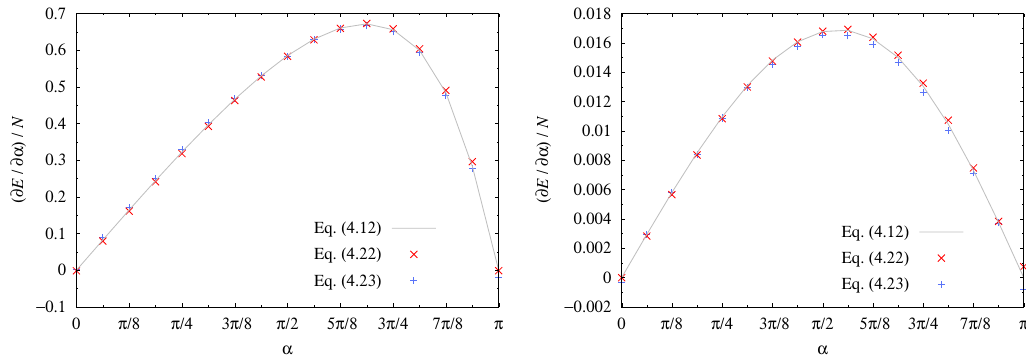
Figure 9. The (cid:11) dependence of the total energy E is numerically evaluated by using eq. (4.22) (red crosses) and eq. (4.23) (blue plus symbols), and compared to the analytic expression eq. (4.12) (the solid line), as a function of (cid:11) . L = 1, (cid:3) = 1 in the left (cid:12)gure; L = 4, (cid:3) = 1 in the right (cid:12)gure, and (cid:11) 2 [0 ; (cid:25) ] in